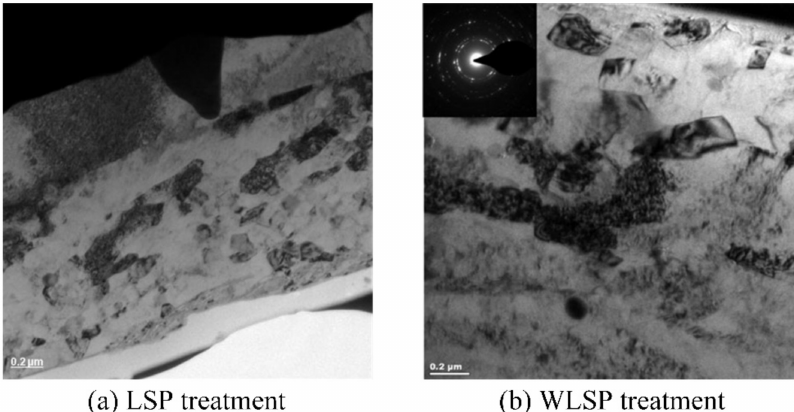
Figure 13. The TEM image for grain structure of AA6061-T6 near the top surface after LSP and WLSP